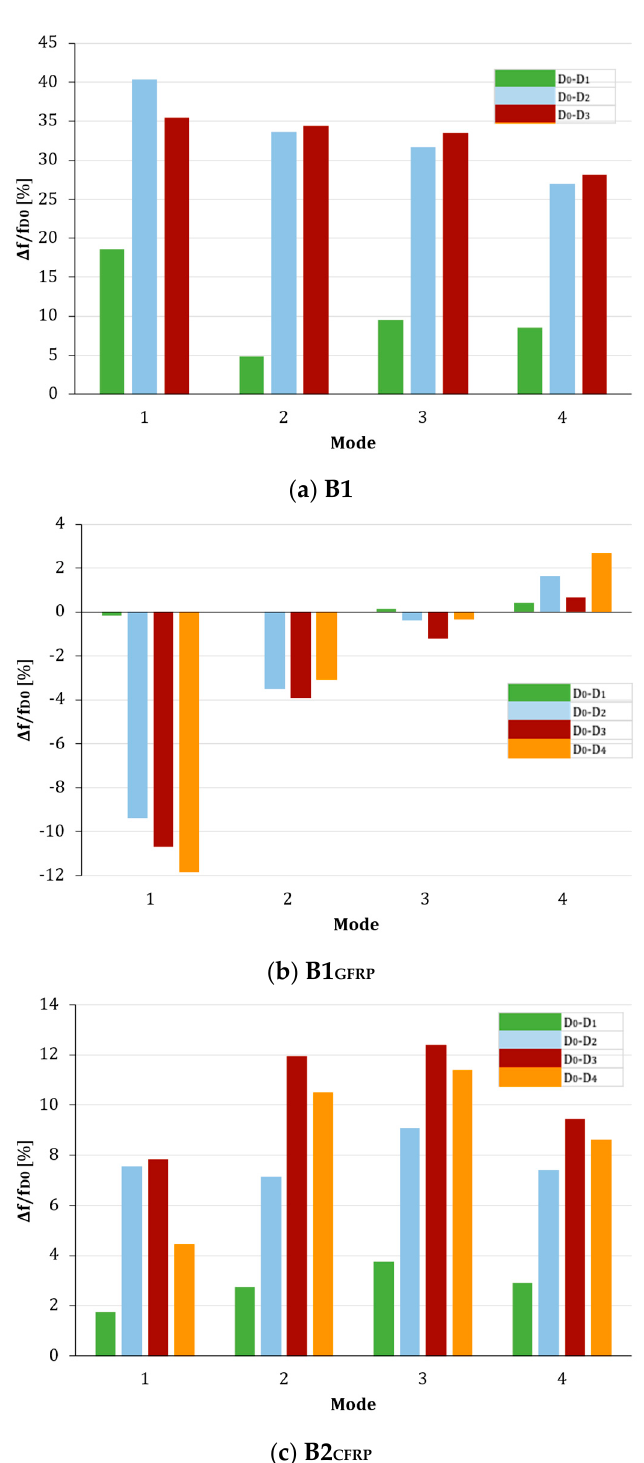
Figure 11. Variation of frequency values at damage D i for each RC beam: ( a ) specimen B1; ( b ) specimen B1 GFRP ; and ( c ) specimen B2 CFRP .